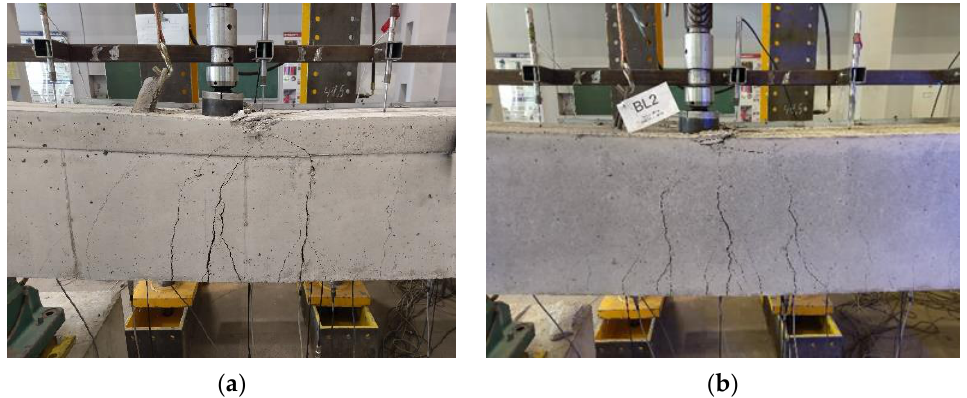
Figure 9. Failure observed at the mid-span zone in BN1 beam ( a ) and BL1 beam ( b ).